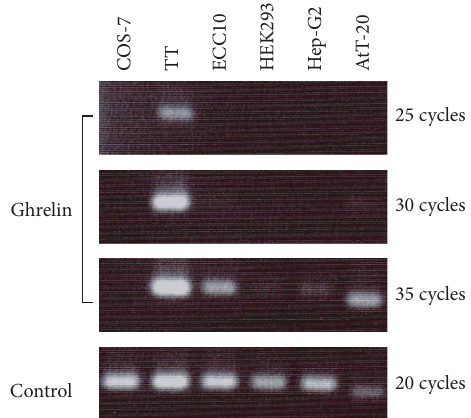
Figure 1: Expression of ghrelin mRNA in cultured cell lines. PCR products were separated by agarose gel electrophoresis and stained with ethidium bromide. Human ghrelin primer set was used for COS-7, TT, ECC10, HEK293, and Hep-G2 cells. Mouse ghrelin primer set was used for AtT20 cell. Controls are human GAPDH for COS-7, TT, ECC10, HEK293, and Hep-G2 cells and mouse ribosomal RNA18 for AtT-20